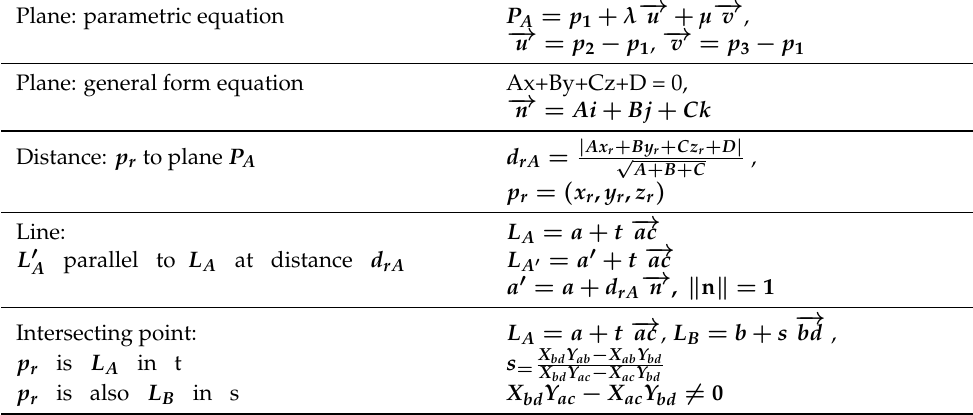
Table 1. Formulation used to correct the user position in the virtual world. Plane: parametric